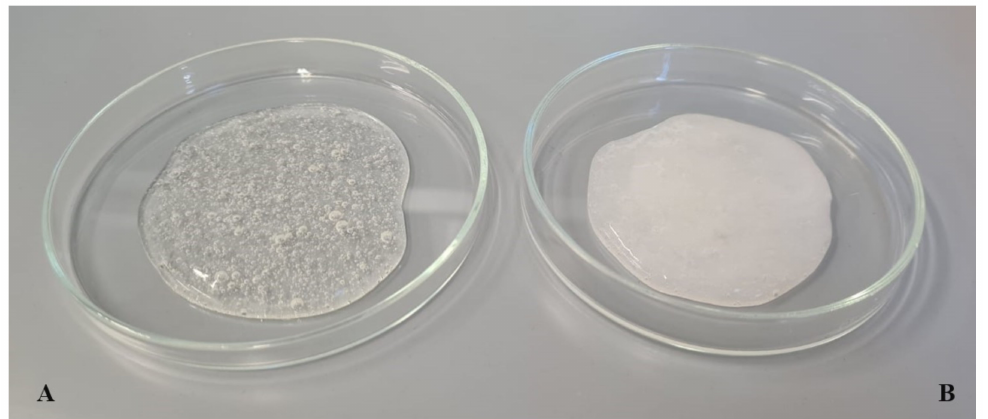
Figure 4. The visual appearance of hydrogel formulation without active ingredients ( A ) . Lipid nanoparticle-containing hydrogel preparation ( B